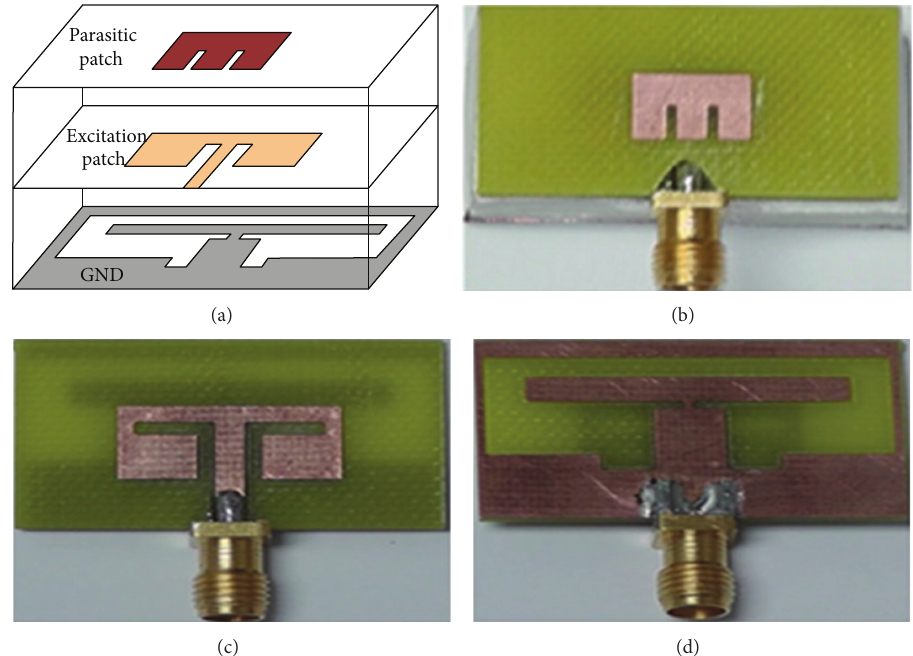
Figure 3: (a) Schematic diagram of the UWB antenna. Fabricated antenna elements, (b) parasitic patch, (c) excitation patch, and (d) defected GND.